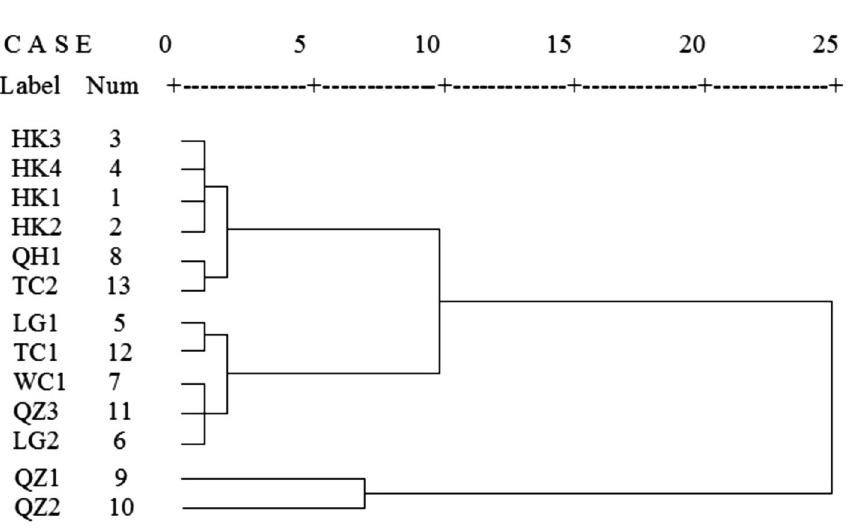
Figure 2. Dendrograms based on the chemical components and contents of EOs of C. lansium seeds.